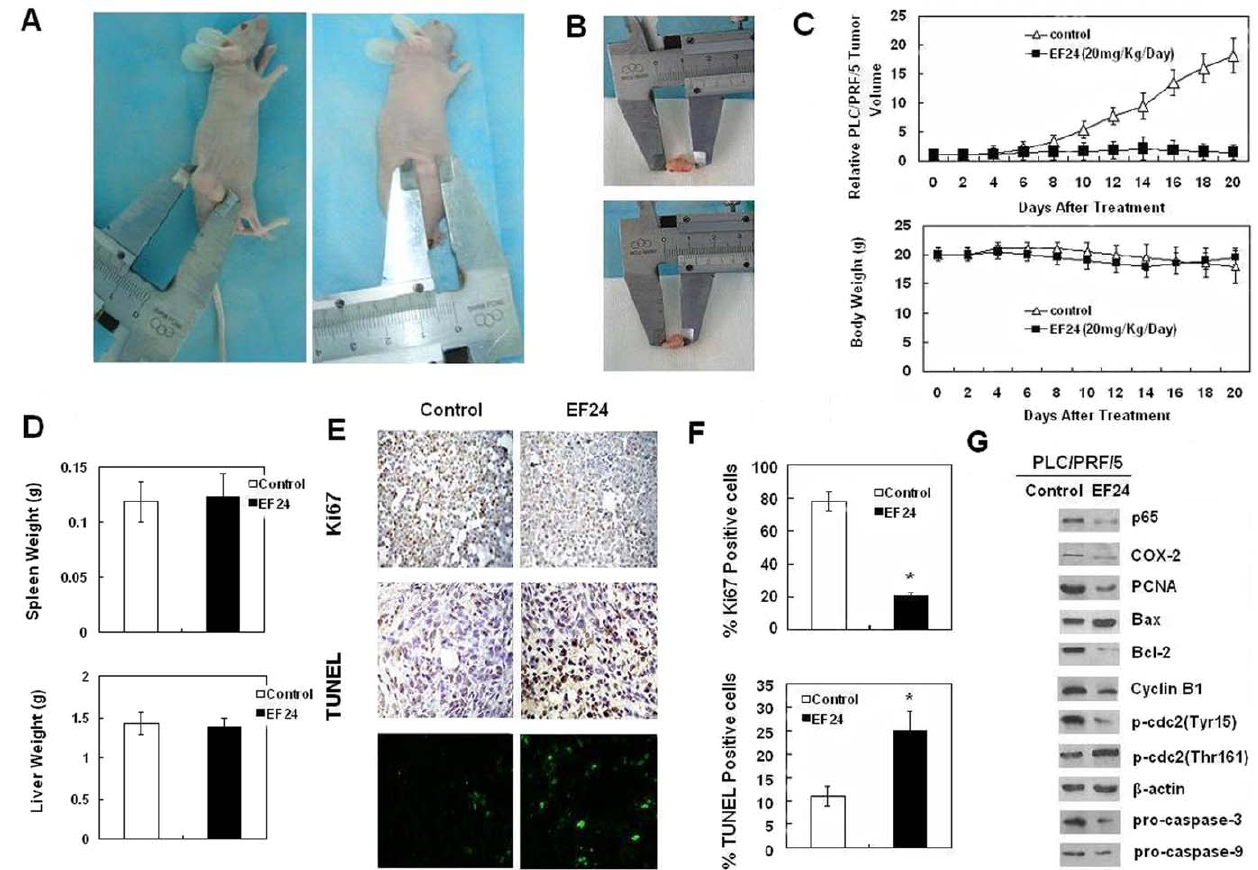
Figure 4. EF24 inhibits liver cancer tumor xenograft growth in vivo. ( A ) and ( B ). PLC/PRF/5 cells were injected to the flanks of nude mice and palpable tumors were allowed to develop for 7 d. Subsequently, 20 mg/kg/d of EF24 was injected daily i.p. for up to 21 d. On day 22, tumors were excised and subjected to further analyses. Tumor volumes in EF24 given mice were smaller than that of control mice. ( C ). Tumor size was measured every two days. There was a significant reduction in relative tumor volume from EF24-treated animals when compared with untreated controls. ( D ). Liver and spleen weight of the nude mice in EF24 treated and control group. ( E ) Tumor sections were stained with an anti-Ki-67 Ab to detect proliferating cells, or TUNEL agent to visualize apoptotic cells. ( F ). Cells expressing Ki-67 were counted to calculate the proliferation index, or TUNEL- positive cells. Assay was done in triplicate and p , 0.05 is denoted by ‘‘*’’. ( G ). Western blot analysis on the expressions of p65, Cyclin B1, p-cdc2 (Thr161), p-cdc2 (Tyr15), Bcl-2, Bax, PCNA, pro-caspase-3 and pro-caspase-9 from respective tumoral homogenate, with b -actin as protein